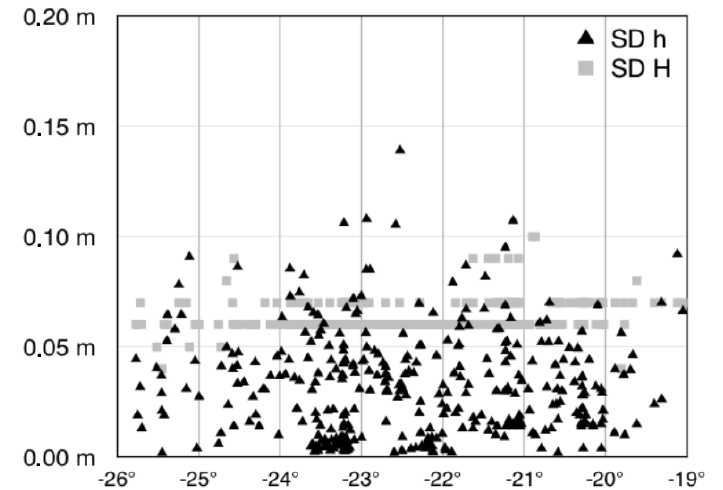
Figure 4 - Standard Deviation of ellipsoidal (h) and ortometric (H) heights.